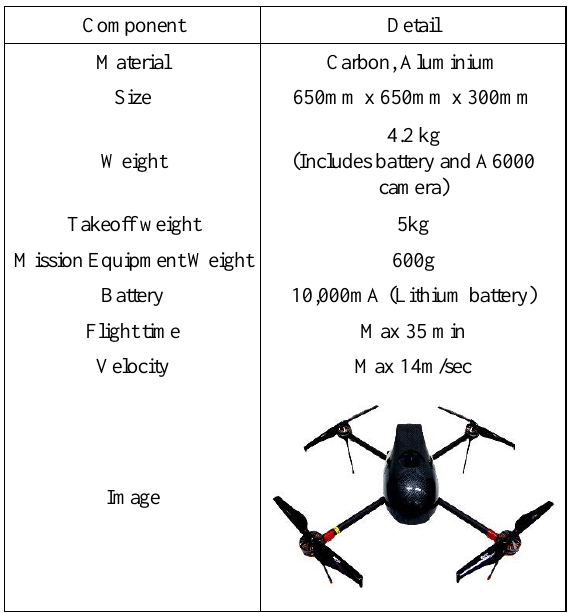
Table 1. The specifications of the test vehicle